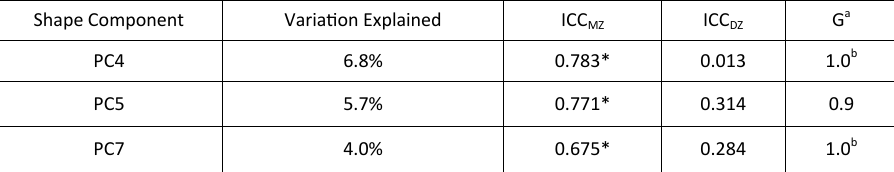
Table 1 . Intraclass correlation coefficients (ICC) and G estimates for principal components showing evi- dence of high heritability. Shape Component Variation Explained